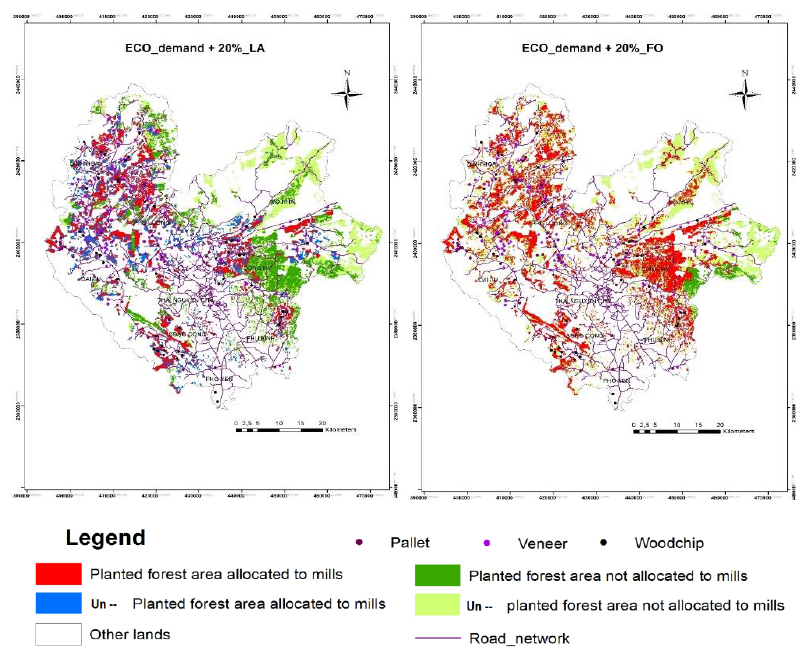
Figure 8. Spatial distribution of land area allocated by increasing timber demand 20% under the landscape approach (_LA) and the current forest approach (_FO).